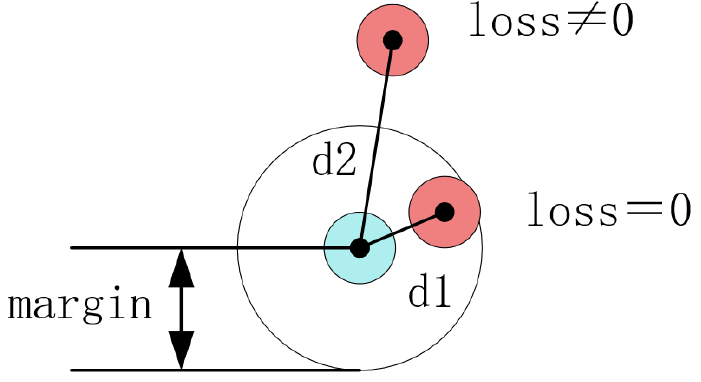
Figure 5. The function of the parameter m.